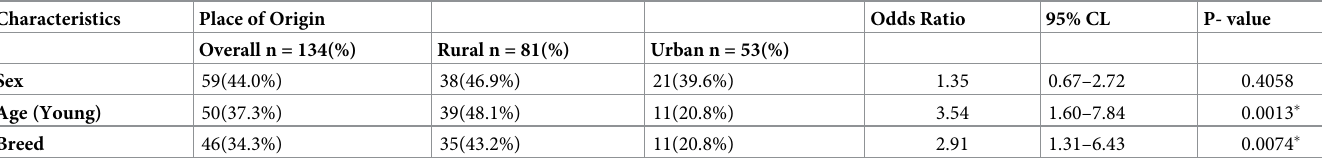
Table 4. Associations between place of origin and cattle carcass characteristics.